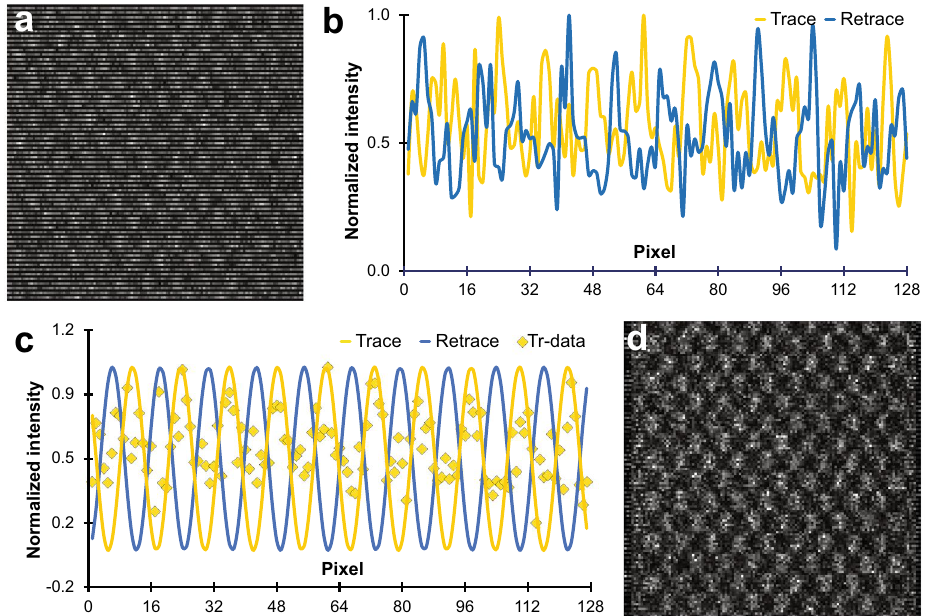
Figure 3. Serpentine scan rectification procedure. ( a ) STEM retrace data (even rows) from Fig. 2c. ( b ) Selected trace and retrace line scans showing maxima mismatch. ( c ) Fourier series fitting of profiles shown in ( b ), trace datapoints are shown for comparison. ( d ) Distortion corrected (rectified) image acquired after minimizing the difference between the trace and retrace